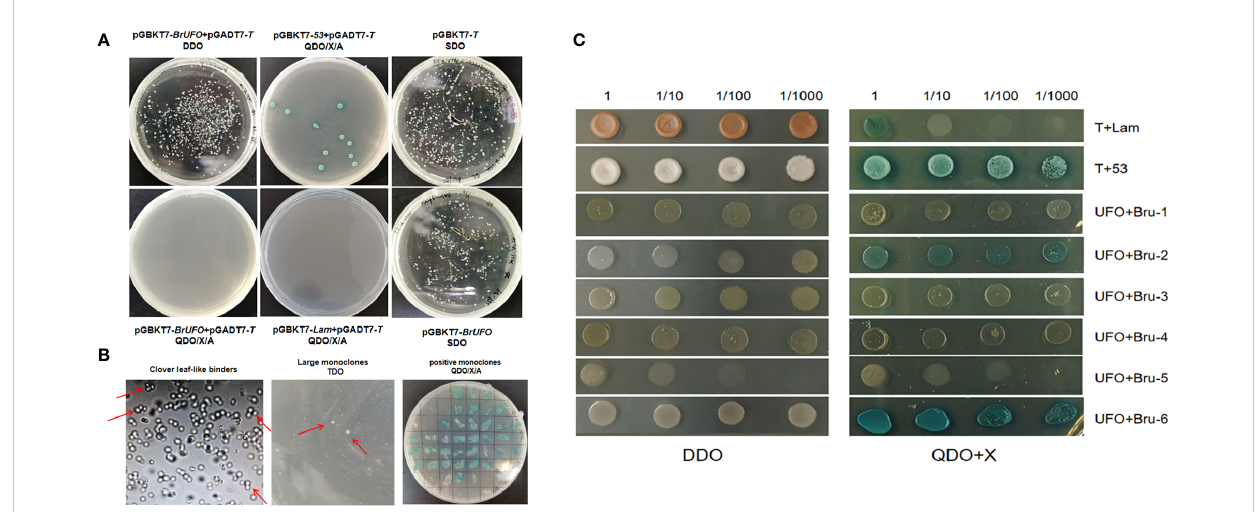
FIGURE 4 Yeast two hybrid test for BrUFO. (A) Self-activation analysis and toxicity testing of pGBKT7- BrUFO. (B) Screening of potentially interacting proteins with BrUFO from the yeast library. Left, Cloverleaf-like binders on TDO medium. Middle, Large monoclonal colonies in TDO transferred to QDO medium. Right, Positive interaction of proteins with BrUFO on DDO/X/A medium. (C) Validation of proteins interacting with BrUFO. Co-transformation results for proteins potentially interacting with BrUFO on DDO medium and QDO+X- a -Gal